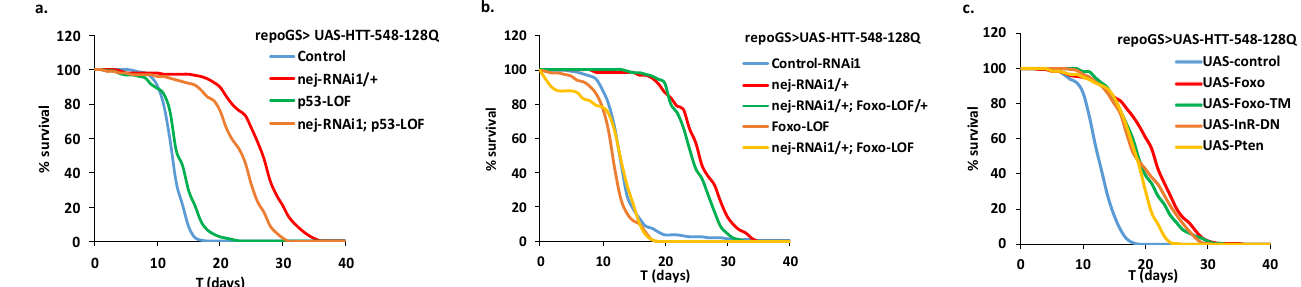
Figure 7. Extended longevity provided by glial depletion of dCBP is Foxo-dependent. We challenged repoGS > UAS-HTT- 548-128Q flies exposed to RU100 to different genetic conditions (see Table S4 for detailed genotypes) and analyzed their lifespan. ( a ) Flies devoid of p53 (p53-LOF) are still strongly responsive to dCBP depletion (nej-RNAi1; p53-LOF) with lifespan increased by 83% compared to controls (MLS = 21.8 vs. 11.9 for controls; n = 100, 205, respectively; pLogRank < 10 −10 ). ( b ) In contrast, flies devoid of Foxo (Foxo-LOF) are unable to respond to dCBP depletion (nej-RNAi1/+; Foxo-LOF) with lifespan similar to controls (MLS = 11.1 vs. 12.9 for controls; n = 107, 180, respectively; pLogRank > 0.2). When only one allele of foxo is lost (nej-RNAi1/+; Foxo-LOF/+), flies are still responsive (MLS = 23.9 vs. 12.9 for controls; n = 104, 180, respectively; pLogRank < 10 −10 ). ( c ) Overexpression of wild type Foxo (UAS-Foxo), activated Foxo (UAS-Foxo-TM) or re- pression of insulin pathway with overexpression of a dominant negative insulin receptor (UAS-InR-DN) or the PTEN phosphatase (UAS-Pten) extend lifespan in repoGS > US-HTT-548-128Q flies. (MLS = 20.1, 18.9, 18.8, 17.4; n = 202, 170, 210, 206; pLogRank < 10 −10 , respectively). Control flies: MLS = 11.9, n = 226.